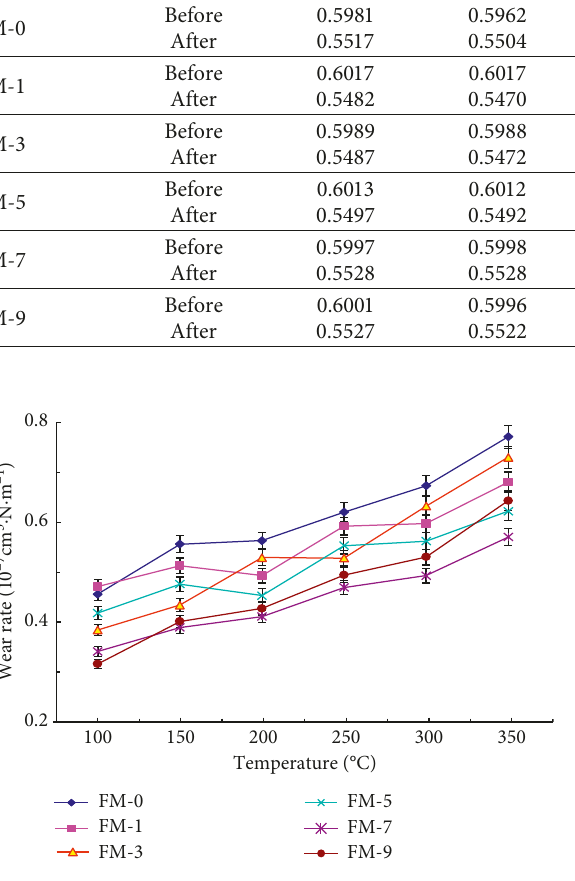
Figure 8: Wear rates of the